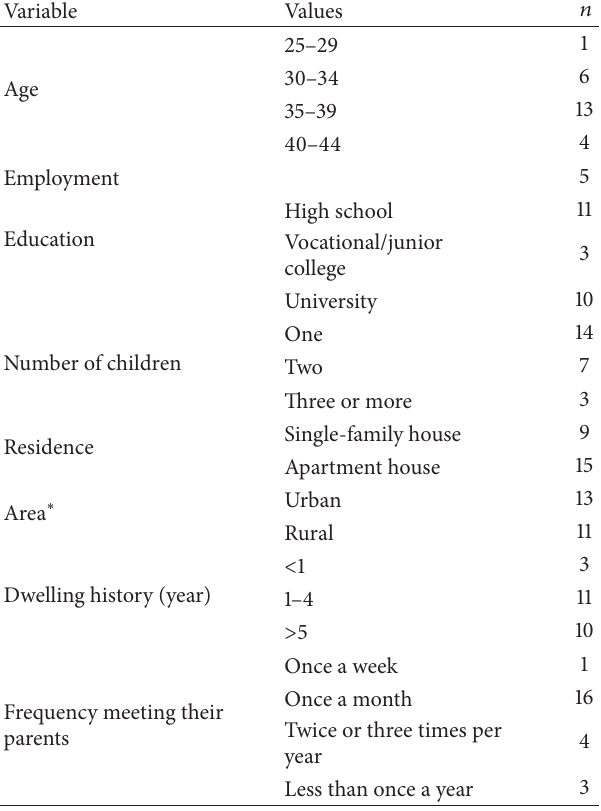
Table 1: Mothers’ demographic